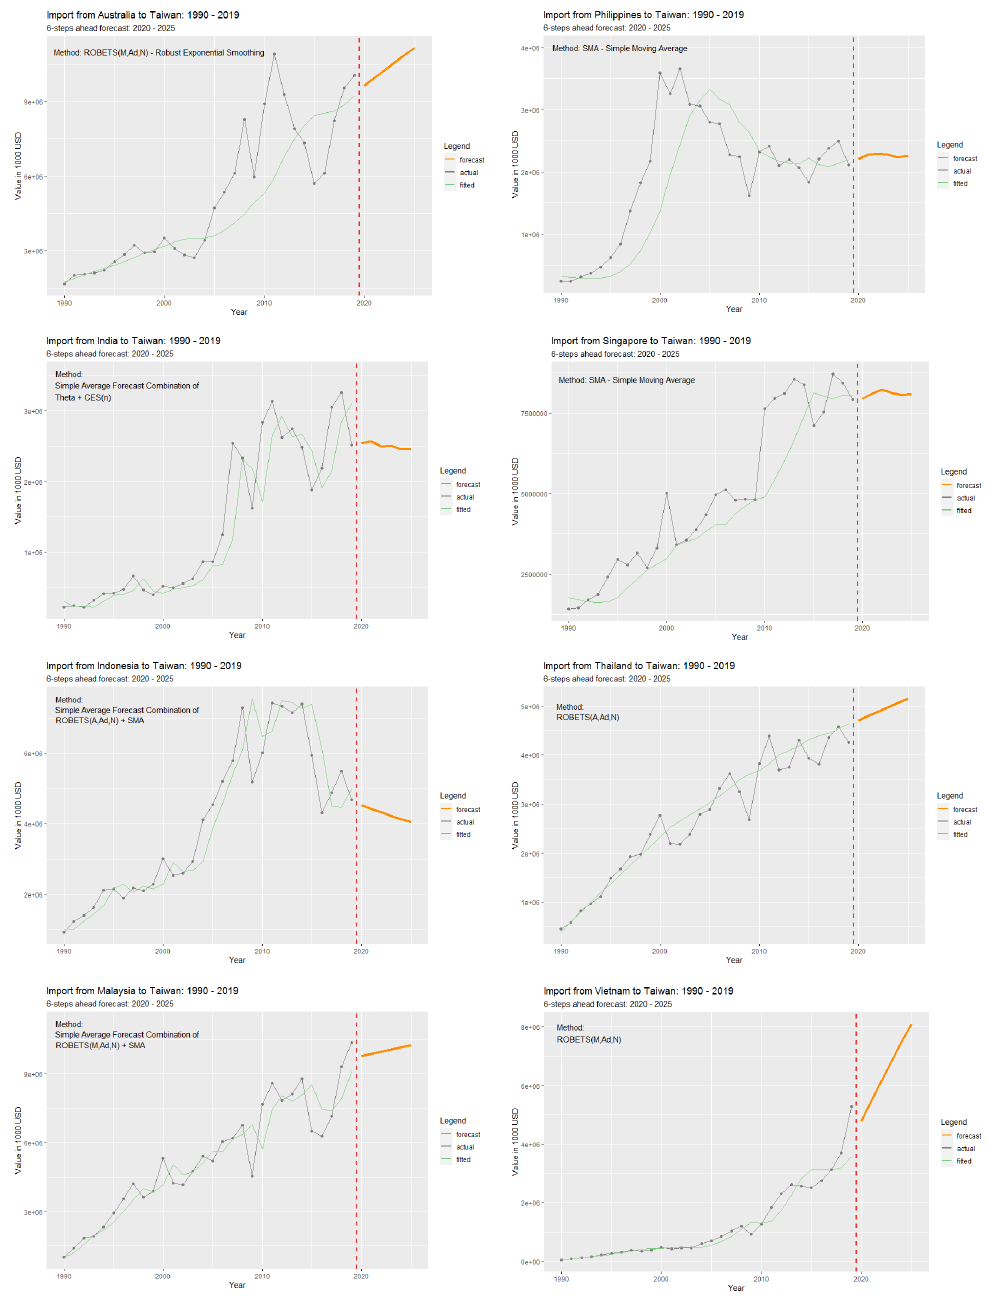
Figure A2. Import forecasts from eight NSP counterparts to